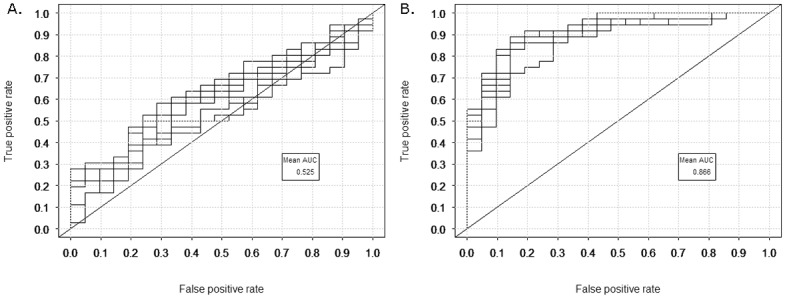
Support vector machine (SVM) classification of fatigue groups.The receiver operator characteristic curves for the SVM output. Ten curves are shown on each plot. The area under the curve (AUC) is calculated as the mean over the ten curves. (A) All 181 enriched pathway genes as input. (B) The 55 leading edge genes as input.